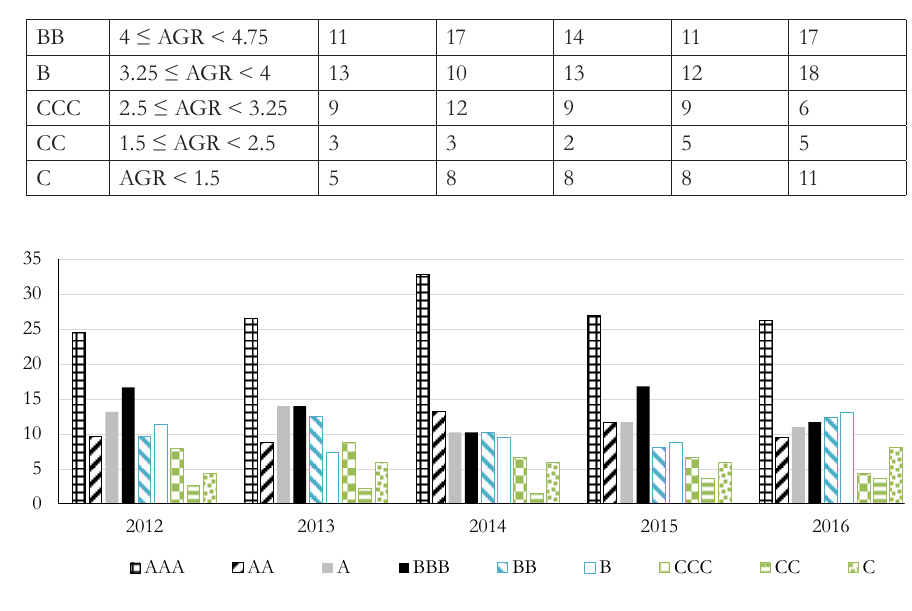
Fig. 1 – Number of non-financial corporations (in %) included in the intervals applicable for Aspect Global Rat- ing. Source: own